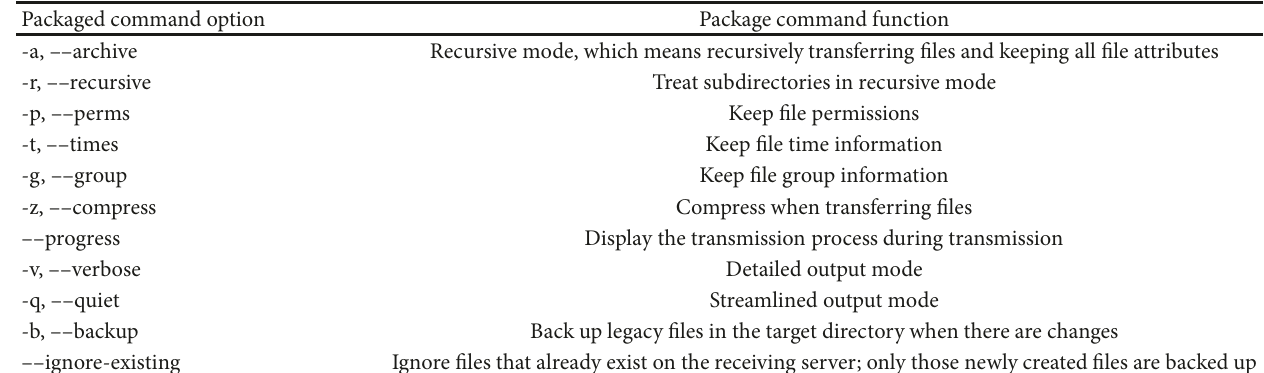
Table 2: Package rsync command table.